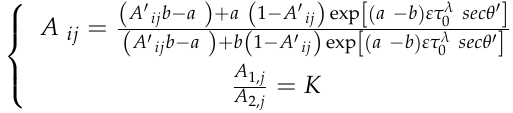
Re-Visiting Spatial Swath Width Resolution